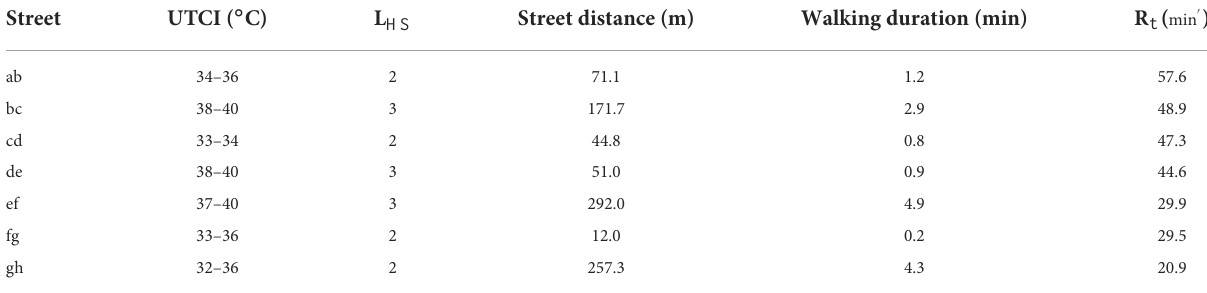
TABLE 4 Dynamic variation of the remaining tolerant heat discomfort of a walking route of